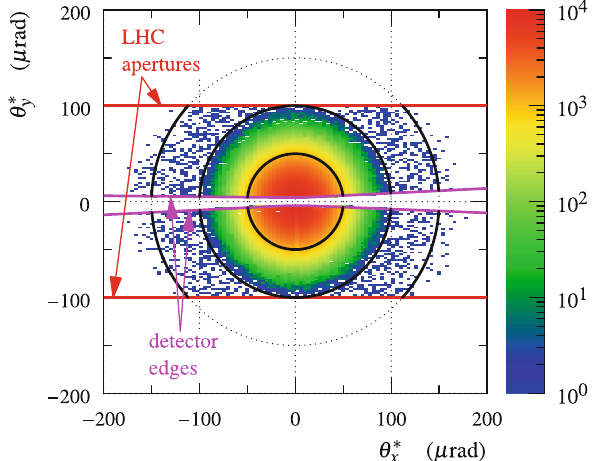
Fig. 8 Single-RPuncorrelatedinefficiencyforthe220-frbottomRPin the right arm. The rapid drop at θ ∗ y ≈ 4 μ rad is due to acceptanceeffects at the sensor edge. The red lines represent a linear fit of the efficiency dependence on the vertical scattering angle (solid) and its extrapolation to the regions affected by acceptance effects